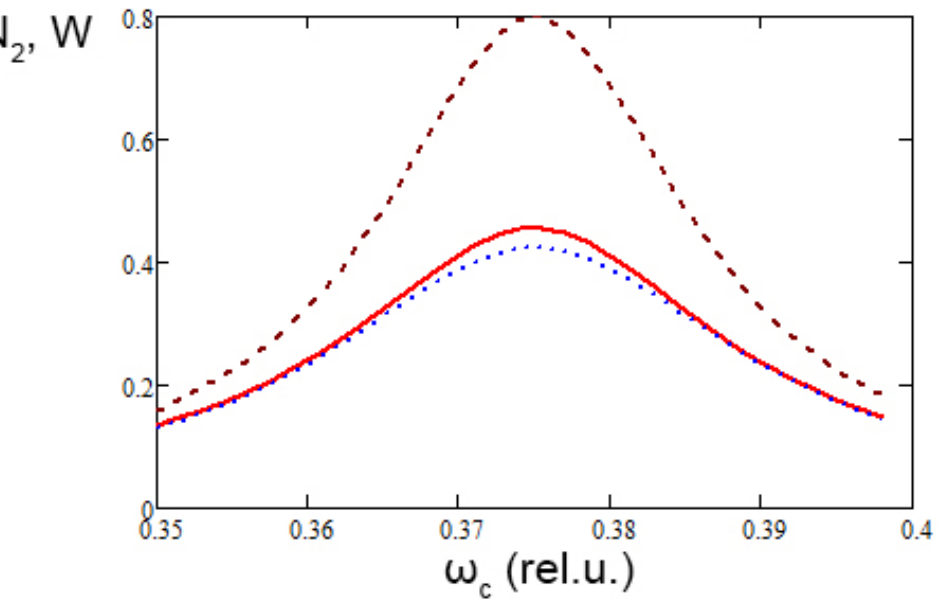
Figure 1. Long pulses τ > T 2 , weak saturation s = 1 ( τ = 400, T 2 = 10 2 , Ω 0 = 0.01): solid line—Bloch equation solution, dotted line—generalized Karplus–Schwinger approach, dashed line—Lorentz profile neglecting saturation.